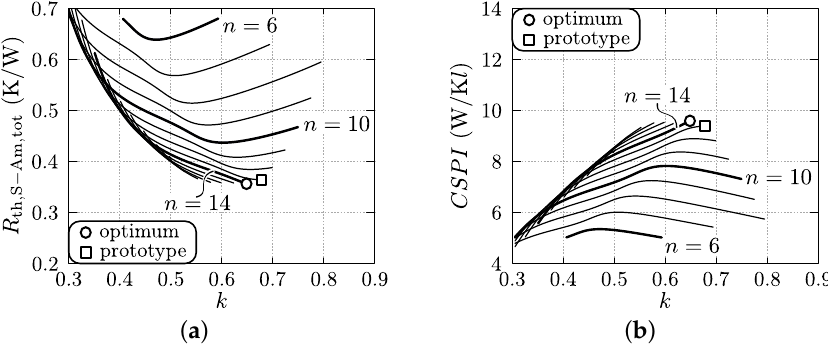
Figure 13. Optimization result for the heat sink of the DAB (geometry with dual-sided base plate, cf. Figure 10), assuming a minimum achievable fin thickness and channel width of 1 mm: ( a ) Total surface-to-ambient thermal resistance R th,S-Am,tot (=0.5 × R th,S-Am ) as function of n and k , which are independently varied; ( b ) Cooling system performance index CSPI as function of n and k